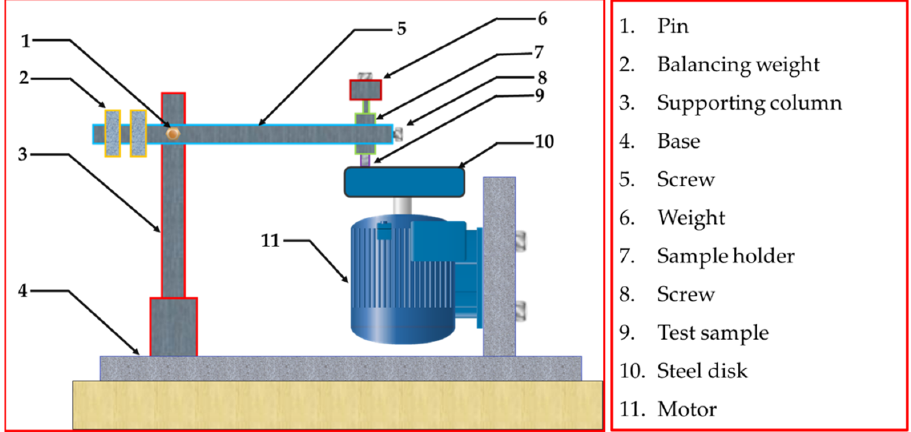
Figure 2. Schematic of homemade pin-on-disk wear testing machine.